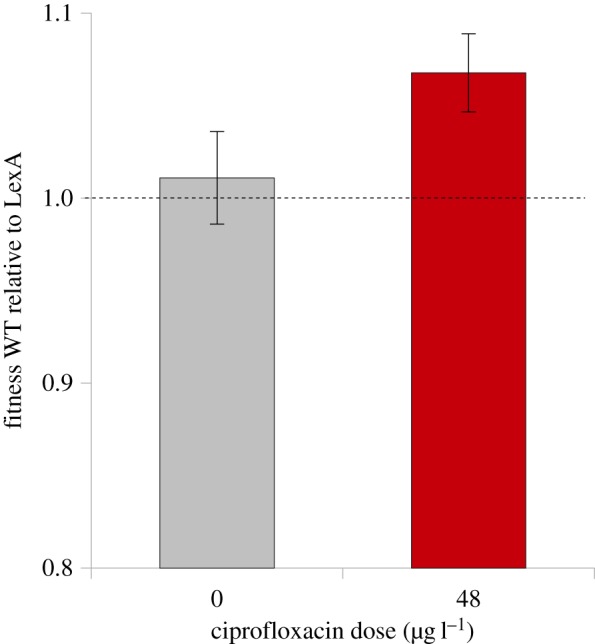
Short-term fitness effects of the SOS response. Competitive fitness of the WT strain relative to the LexA mutant, as measured using overnight competition experiments. Values are the average of 20 independent replicates starting from different WT : LexA frequencies and error bars are s.e.m. The dashed line represents no relative fitness difference (value of 1).